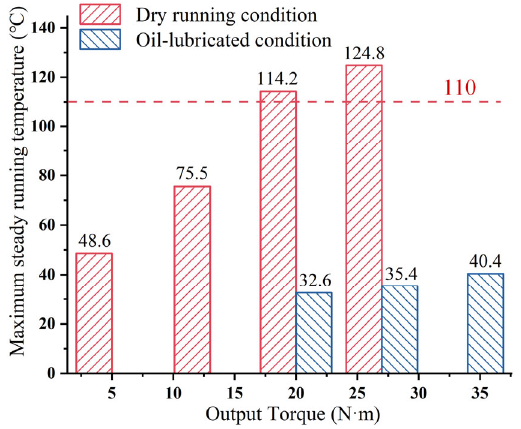
Fig. 21 Maximum steady running temperature at different loading